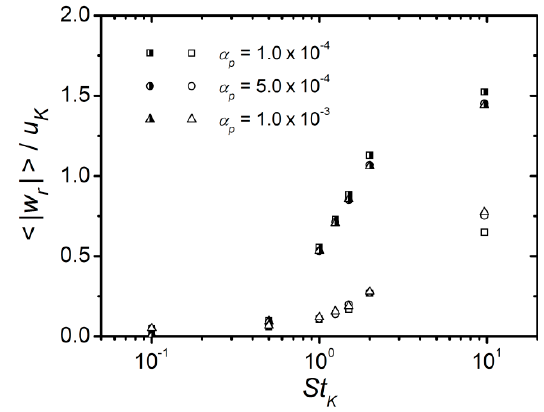
Figure 13. Modulus of mean radial relative velocity (RRV) between particle pairs, w r = w · r / | r | , as a function of the particle Stokes number normalised by the Kolmogorov velocity, u K . Half-closed symbols represent colliding particles while open symbols denote the average of close particle pairs at a distance lower than r = 3 d p /2 based on Eulerian evaluations of the radial distribution.